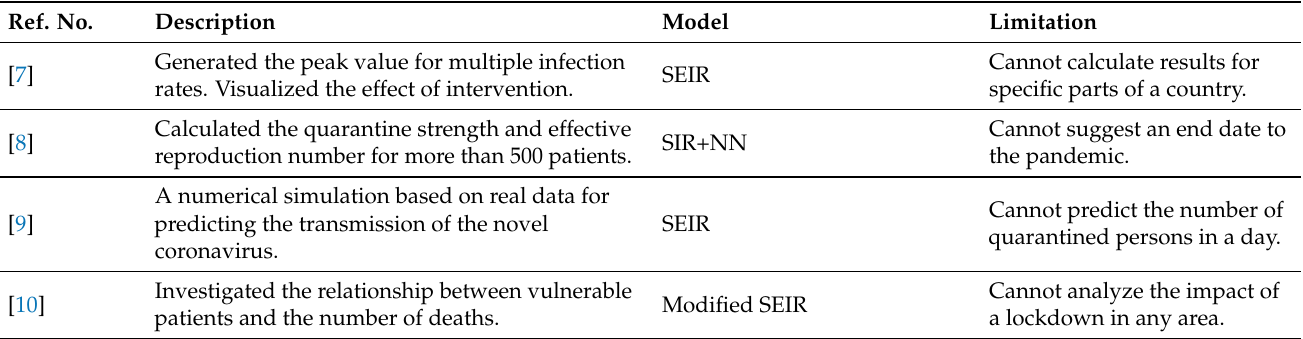
Table 1. Related